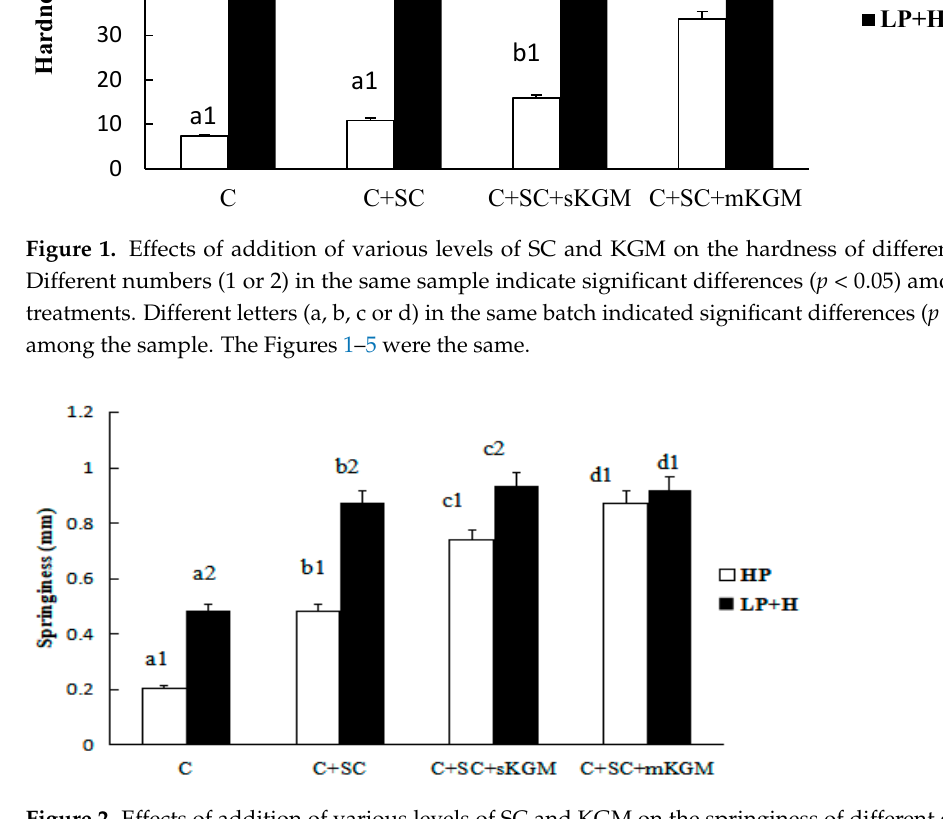
0.2 00.1 Figure 3. Effects of addition of various levels of SC and KGM on the cohesiveness of different gels. Figure 4. Effects of addition of various levels of SC and KGM on the gumminess of different gels.